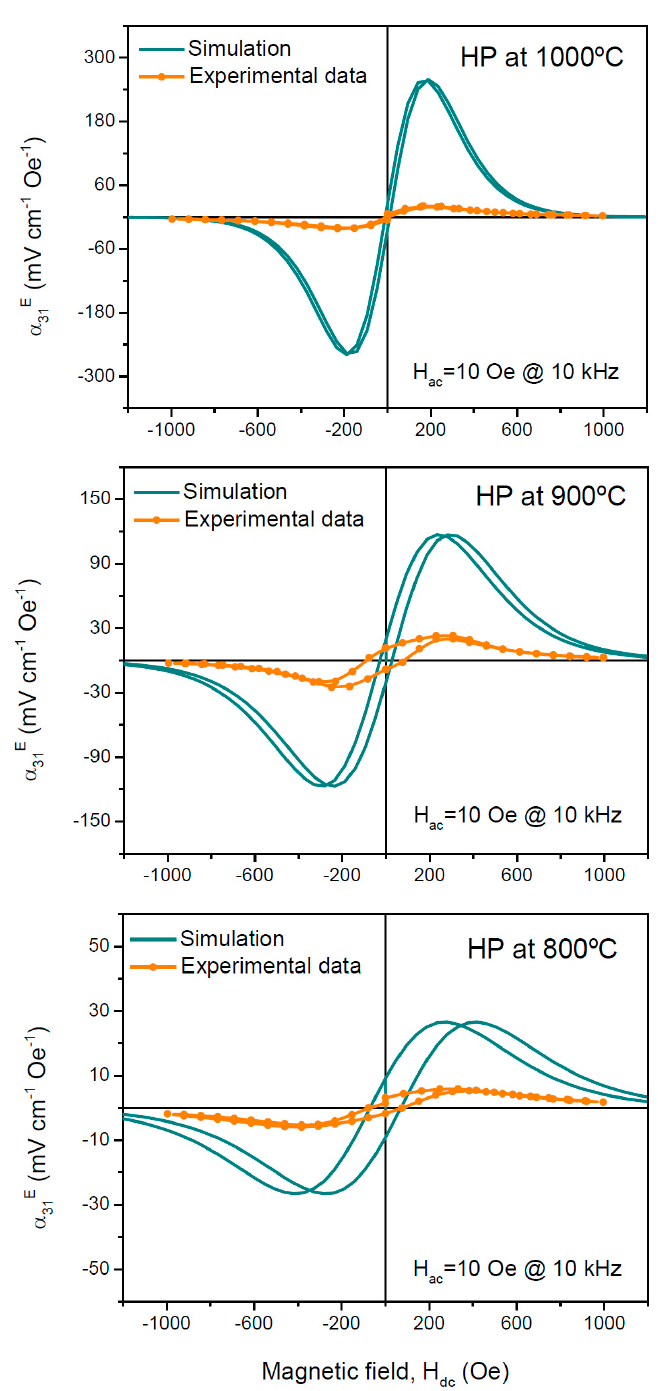
Figure 4. Comparison of experimental results for Bi 0.36 Pb 0.64 Sc 0.36 Ti 0.64 O 3 /NiFe 2 O 4 /Bi 0.36 Pb 0.64 Sc 0.36 Ti 0.64 O 3 1 mm/1 mm/1 mm three-layer composite discs with 8 mm diameter, processed by SPS at decreasing temperature, with results obtained by the simulation of three-layer structures.